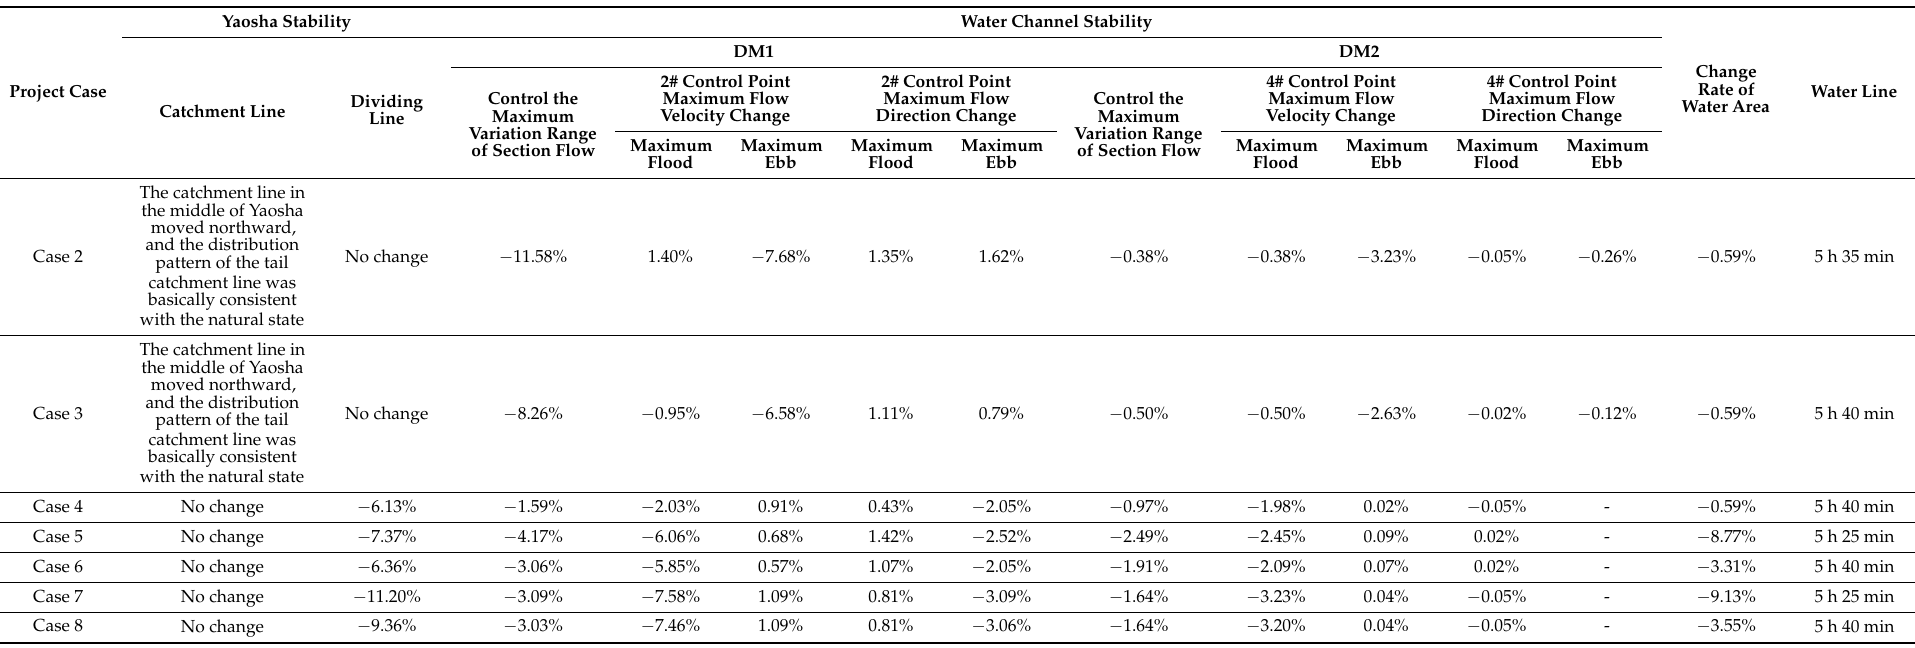
Table 4. Comparison of different reclamation project